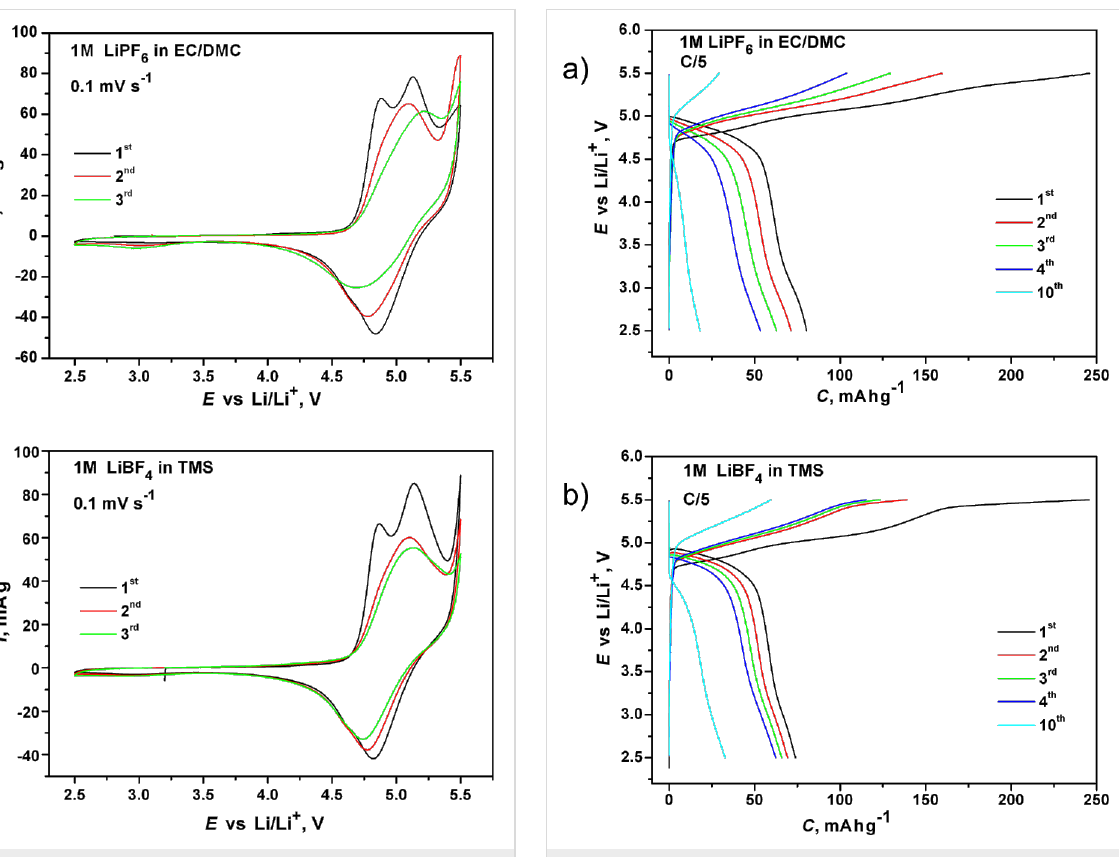
Figure 8: Charge–discharge curves of Li 2 Co 0.9 Mn 0.1 PO 4 /C in the commercial (a) and the sulfone-based (b) electrolytes measured at